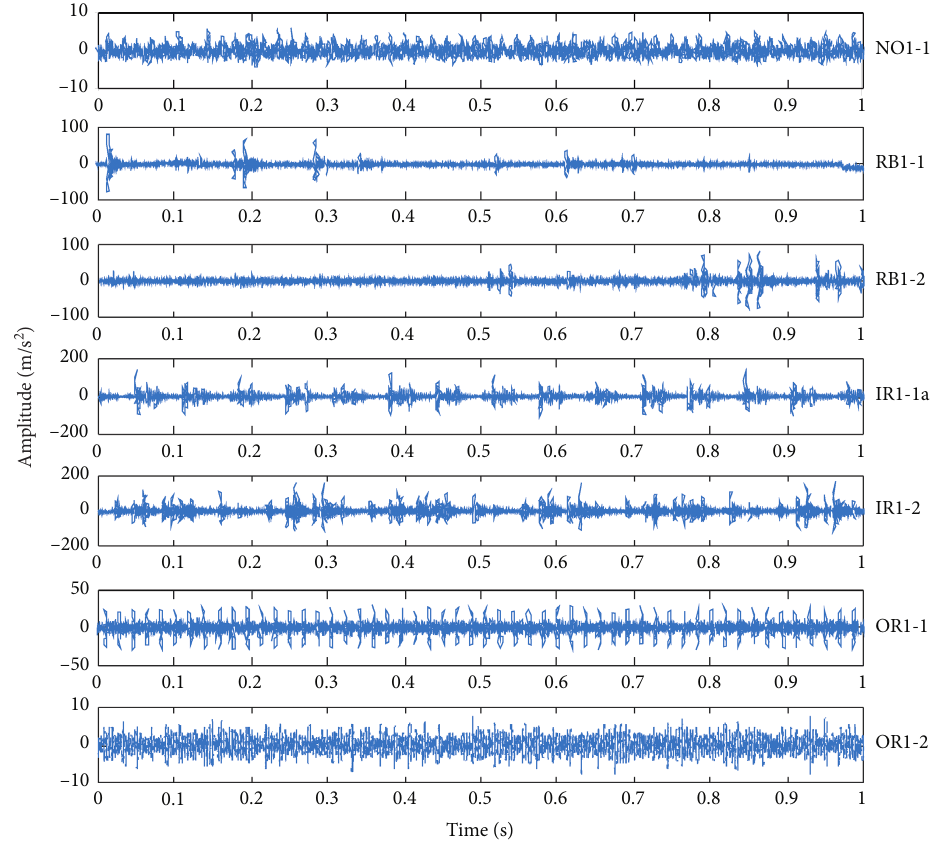
Figure 5: The time-domain signals of seven operation conditions. Table 2: Description of the operation conditions in experiment